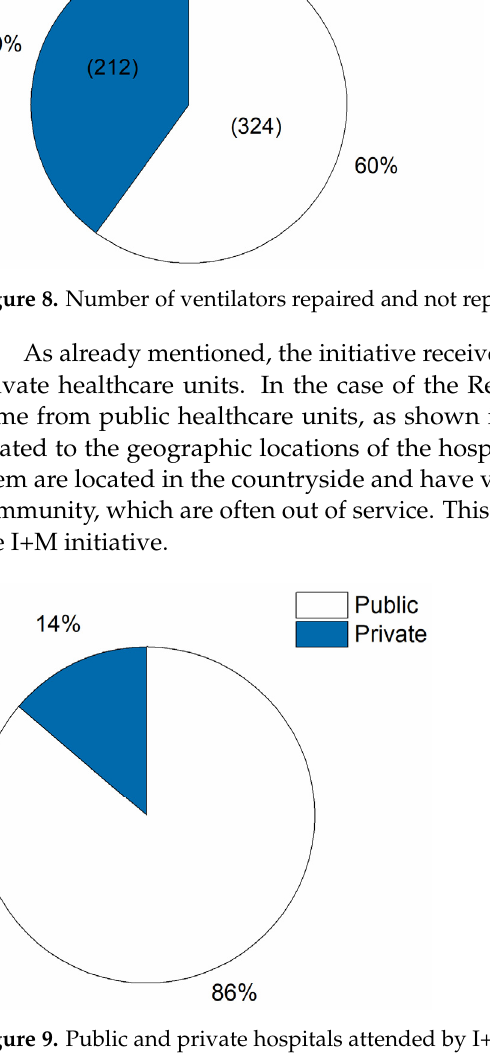
Figure 9. Public and private hospitals attended by I+M initiative in Bahia state.